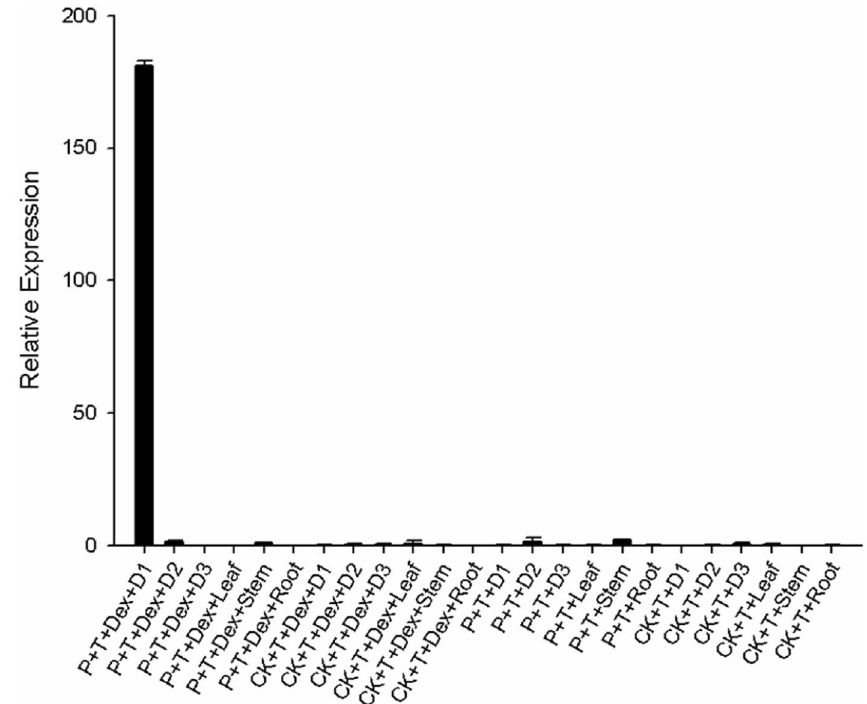
Figure 6. Transcriptional levels of DTA gene on the axillary buds of the 1st, 2nd and 3rd leaves, the 1st leave, the stems and roots after topping of positive transgenic plants/control plants applied with/without 50 µM DEX. P: positive transgenic plants; T: topping; Dex: 50 µM dexamethasone; D1: axillary buds of the 1st leaves; D2: axillary buds of the 2nd leaves; D3: axillary buds of the 3rd